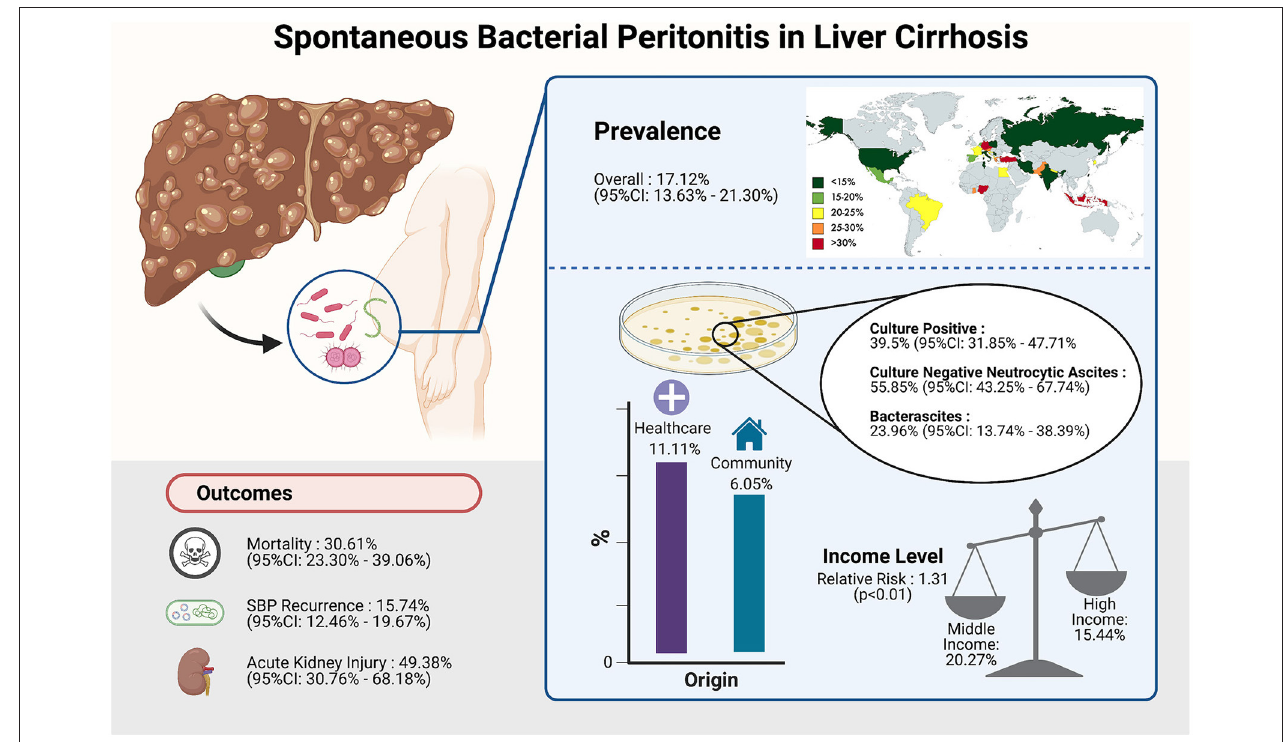
FIGURE 5 | Summary of the prevalence of SBP and its associated outcomes. Image created with Biorender.com.